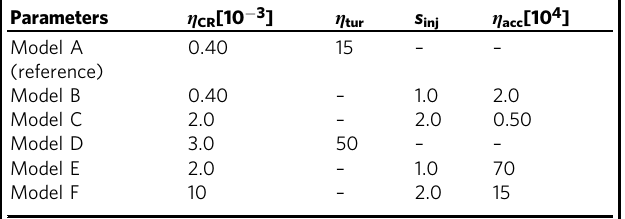
Table 3 Parameters for models for PeV neutrinos (A, B, C) and 10 – 100 TeV neutrinos (D, E,